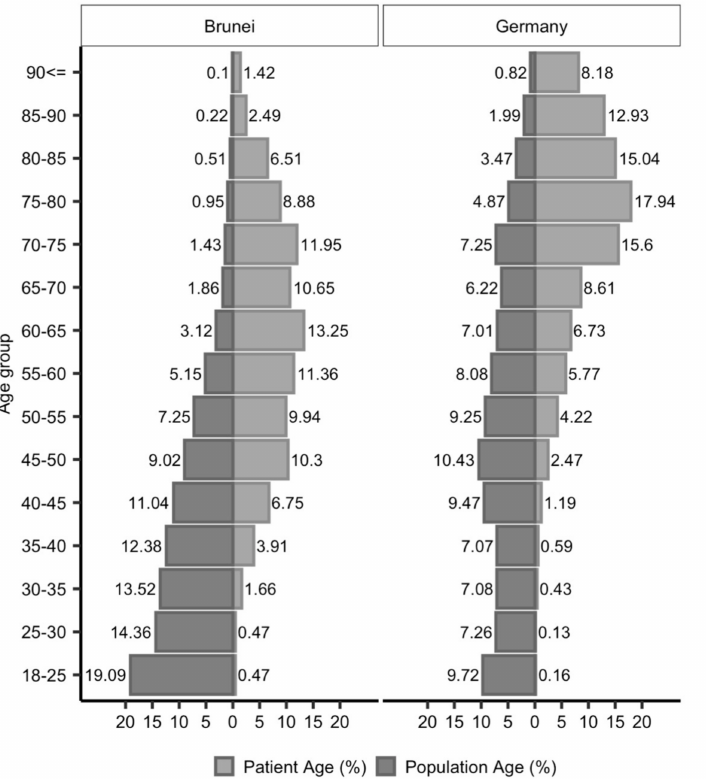
Figure 1. The Age Distribution of Stroke Patients in Conjunction with Demographic Population